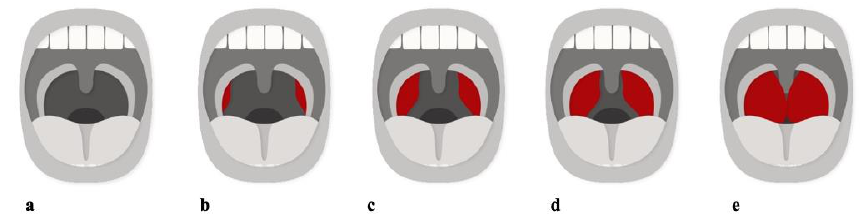
Figure 5. Tonsil Grading System. ( a ) Size 0, absence of tonsillar tissue. ( b ) Size 1, tonsils within the pillars. ( c ) Size 2, tonsils extended to the pillars. ( d ) Size 3, tonsils extended past the pillars. ( e ) Size 4, tonsils extended to the midline. Adapted from Friedman [48].